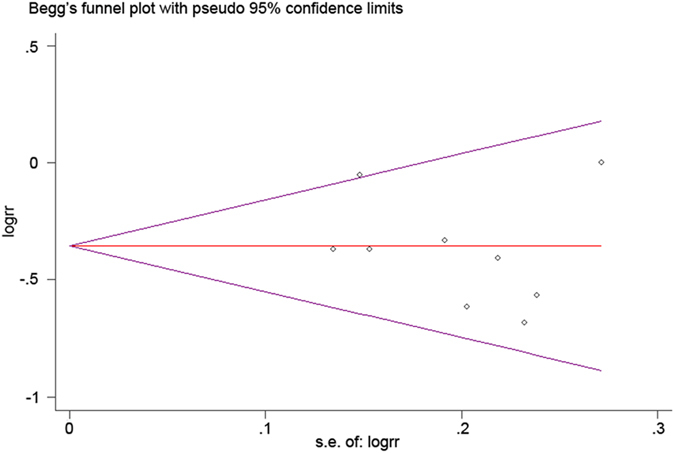
Begg’s test results of renal cell carcinoma patients’ 5-year OS rate.